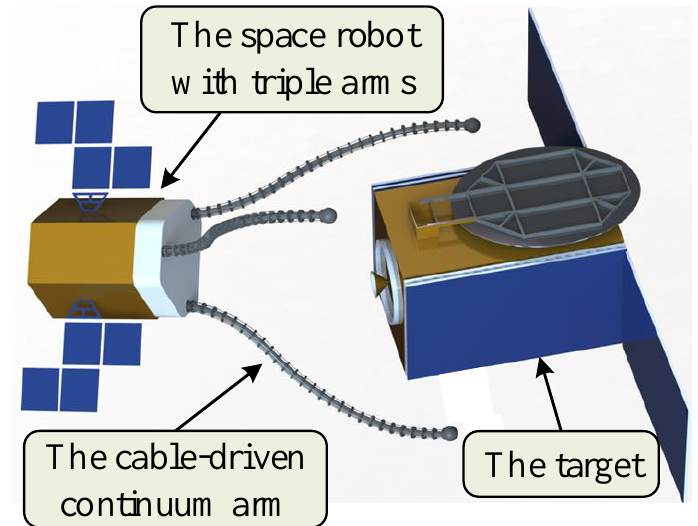
Figure 1. The concept of grasping through space robot with triple arms.